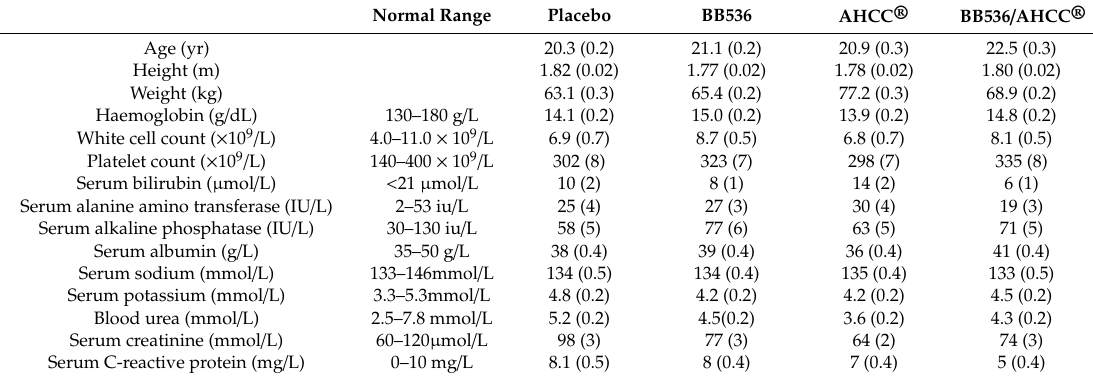
Table 2. Baseline characteristics of volunteers in the 4 treatment groups. Values presented are mean